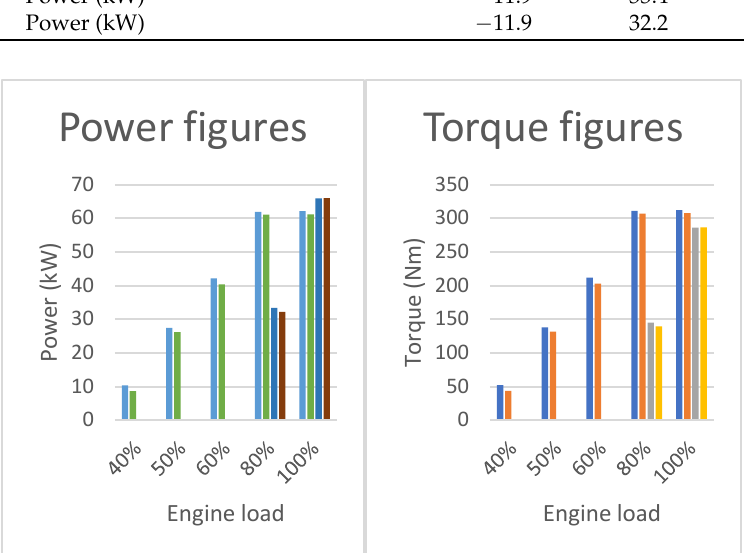
Figure 5. Design of a resonant cell [12].